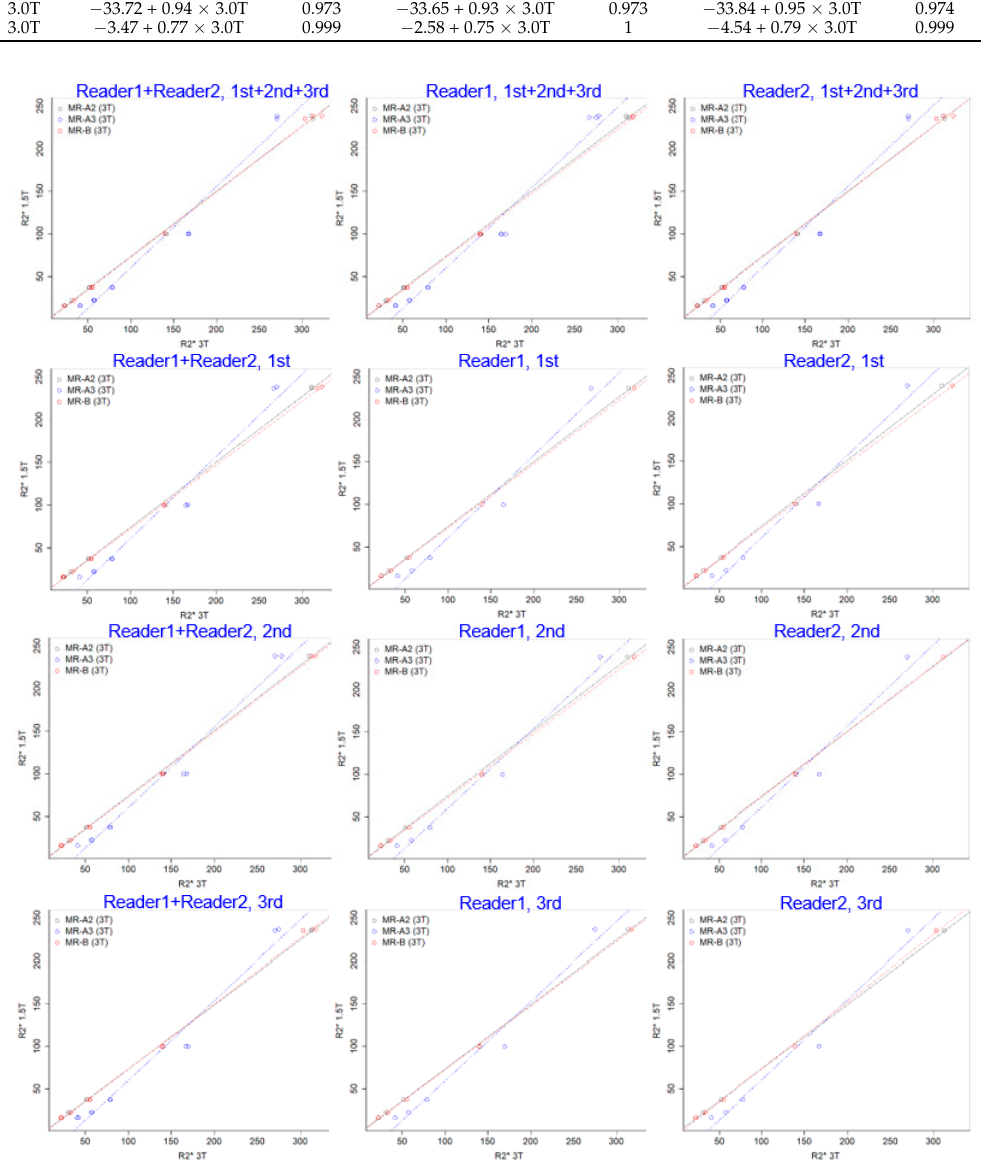
Figure 2. Scatter plots of a phantom with linear regression with repeated measures by two radiologist readers.